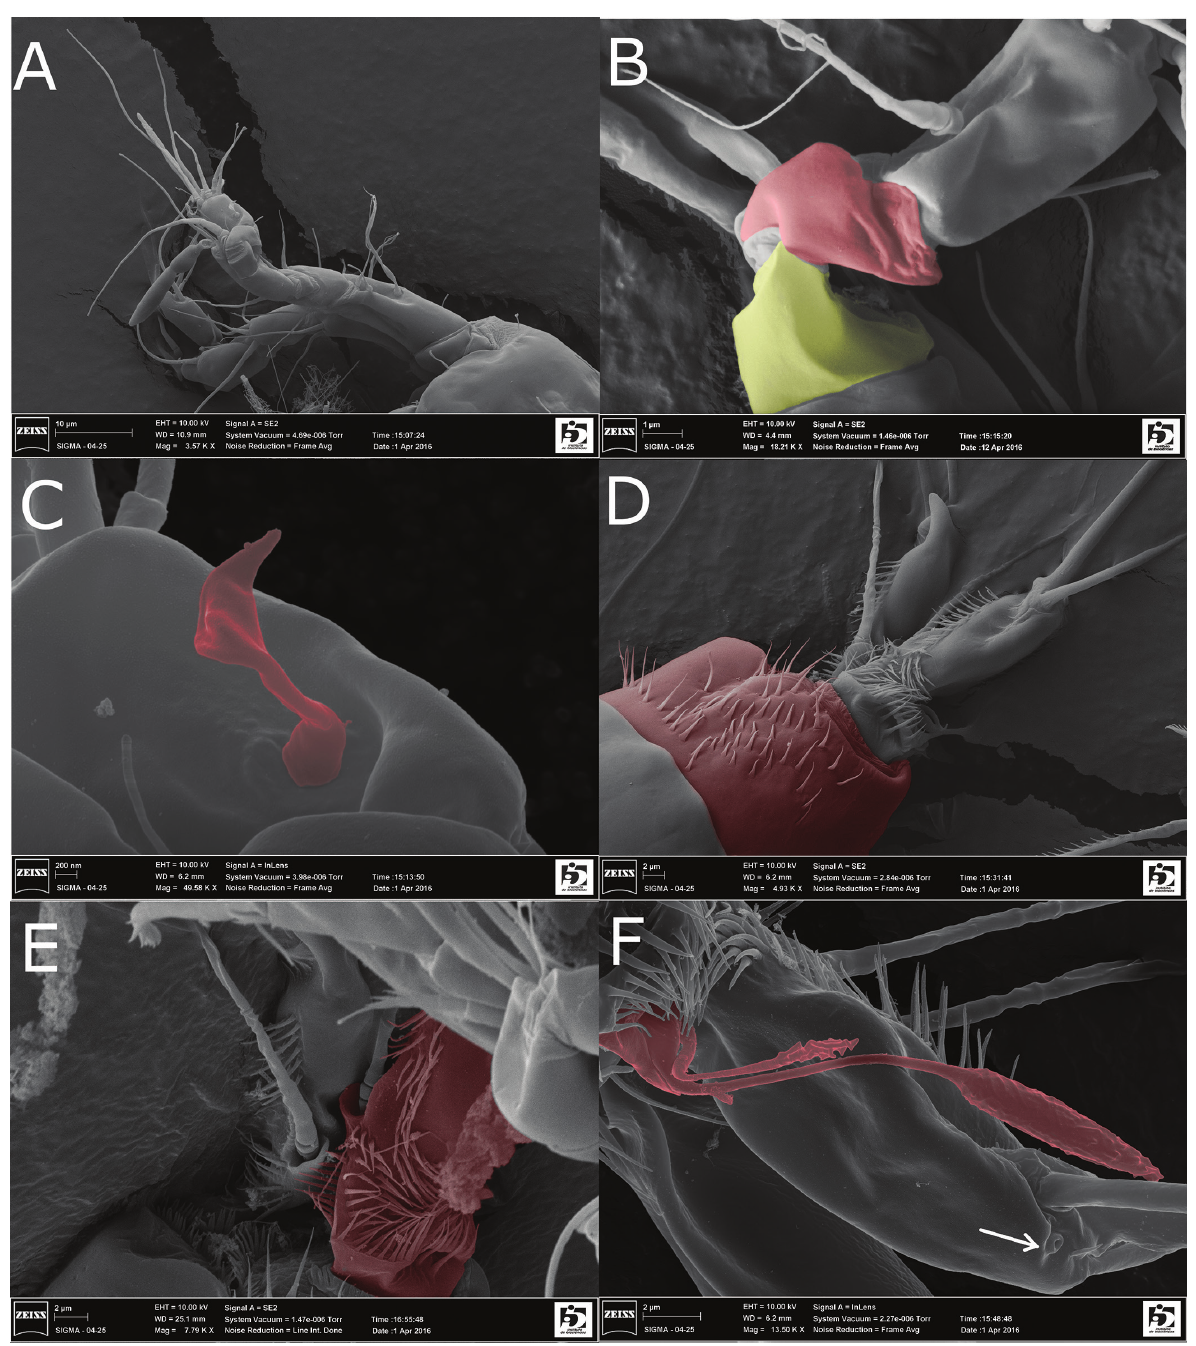
Figure 6. SEM image of Eirinicaris antonioi sp. n. Male: A antennule in lateral view; B antennule segments 6 (yellow) and 7 (cor- al); C antennule, segment 8 showing modified seta; D telson and furca, lateral; E furca, dorsal view; F furca, ventral view, showing modified setae I, II and III and distal pore arrowed. Scale bars A = 10µm; B = 1µm; C = 200µm; D = 2µm; E = 2µm; F =